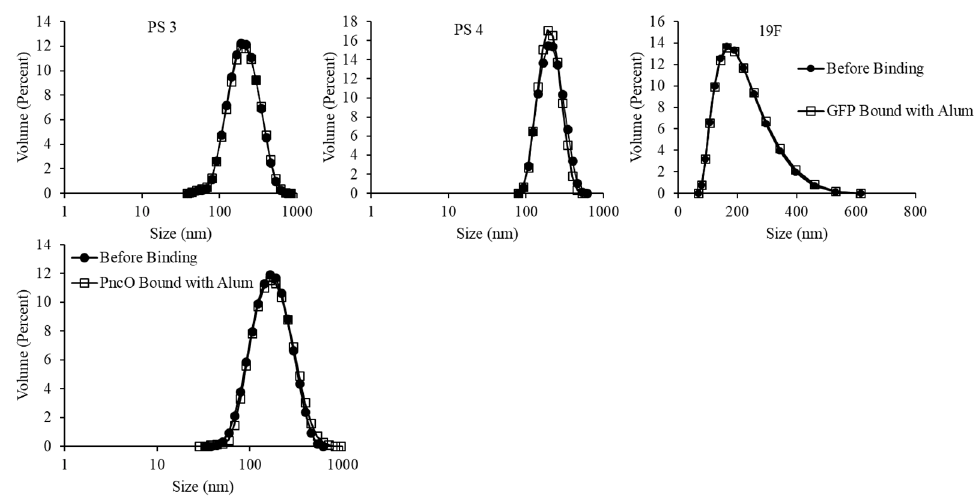
Figure 7. Size distribution analysis of LEPS particles with and without GFP/PncO/alum addition. Data presented with PncO utilized polysaccharide (PS) 3.